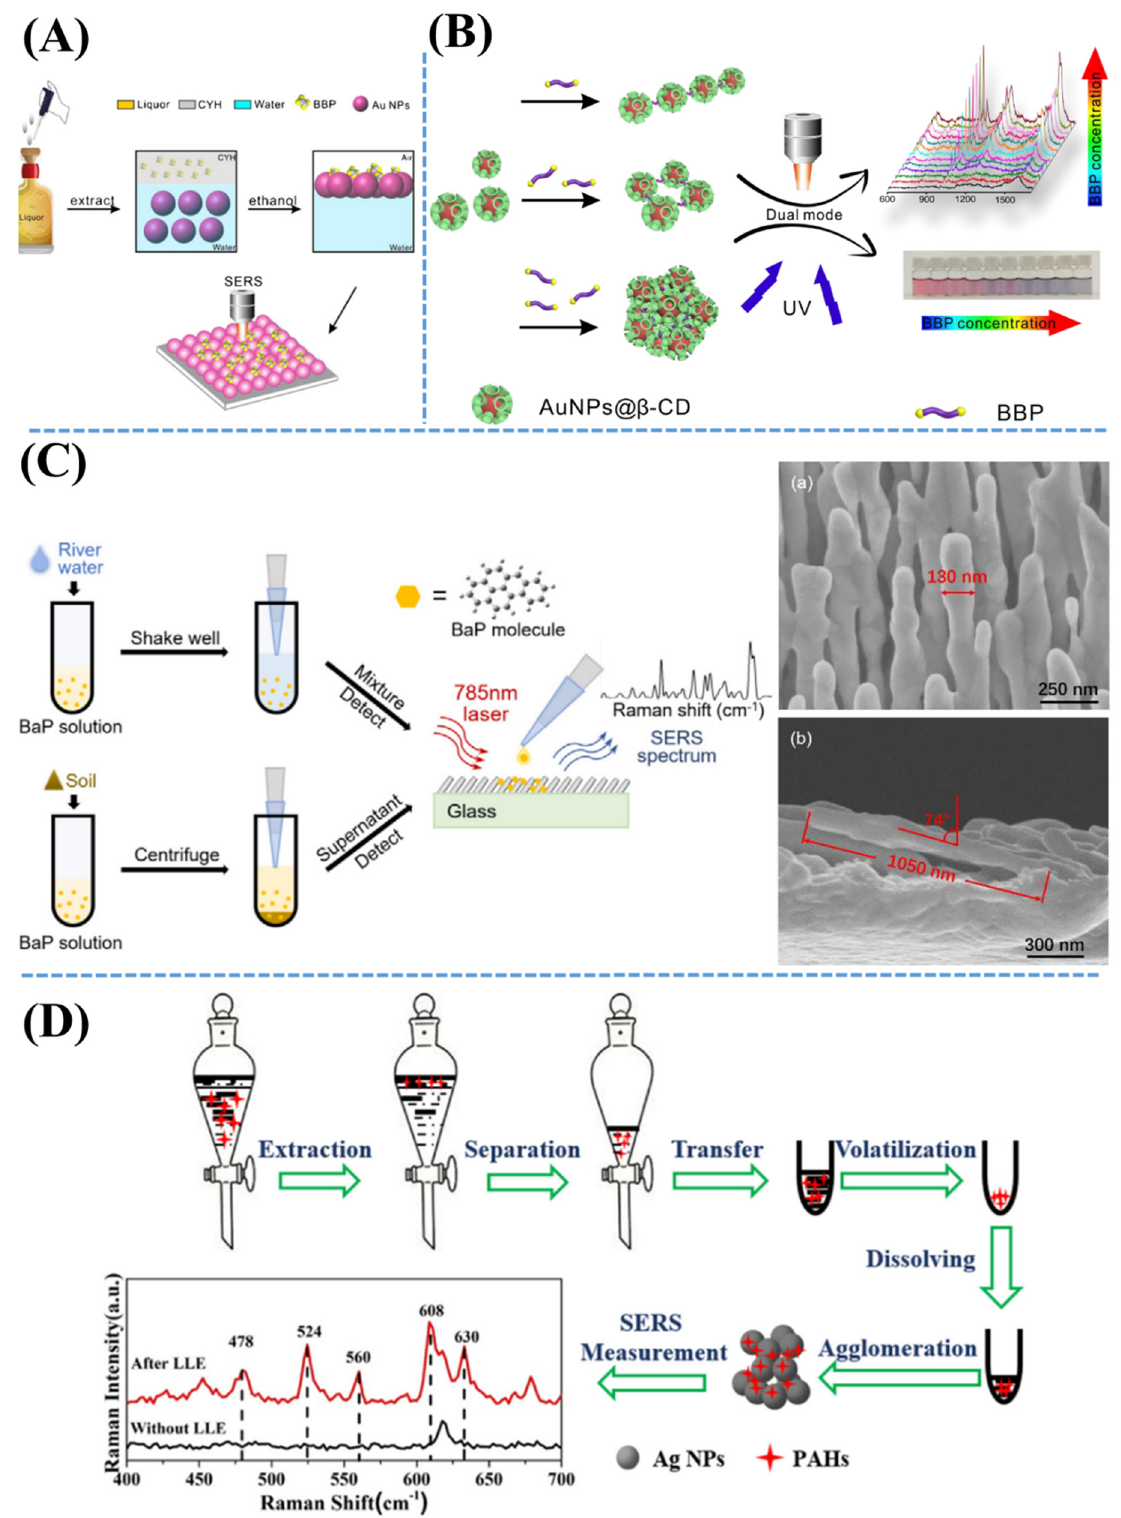
Figure 2. ( A ) Schematic illustration of the self-assembly of AuNPs arrays-introduced SERS detection of BBP after a process of molecule extraction from liquor by CYH. Adapted from [65]. ( B ) Diagram of BBP detection using β -cyclodextrin-stabilized AuNPs by means of either SERS spectra or colorimetric sensing. Adapted from [66]. ( C ) Demonstration of the silver nanorod (AgNR) substrate-based SERS detection for BaP. Inserted SEM images show ( C – a ) top-view and ( C – b ) cross-sectional view of AgNR substrate. Adapted from [67]. ( D ) Diagram of trace detection of polycyclic aromatic hydrocarbons (PAHs) using AgNP-assisted SERS technology. Adapted from [61].